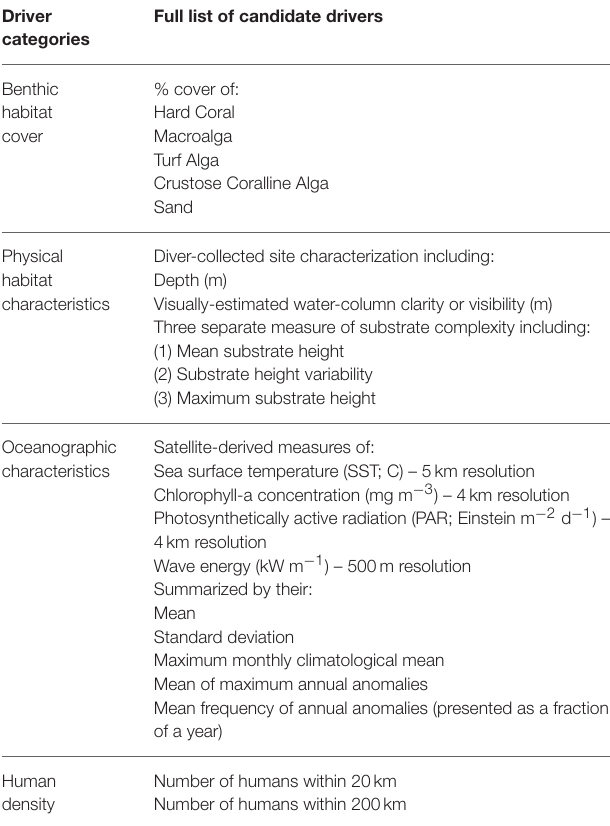
TABLE 1 | List of all candidate drivers for modeling total and herbivorous reef fish in the main Hawaiian